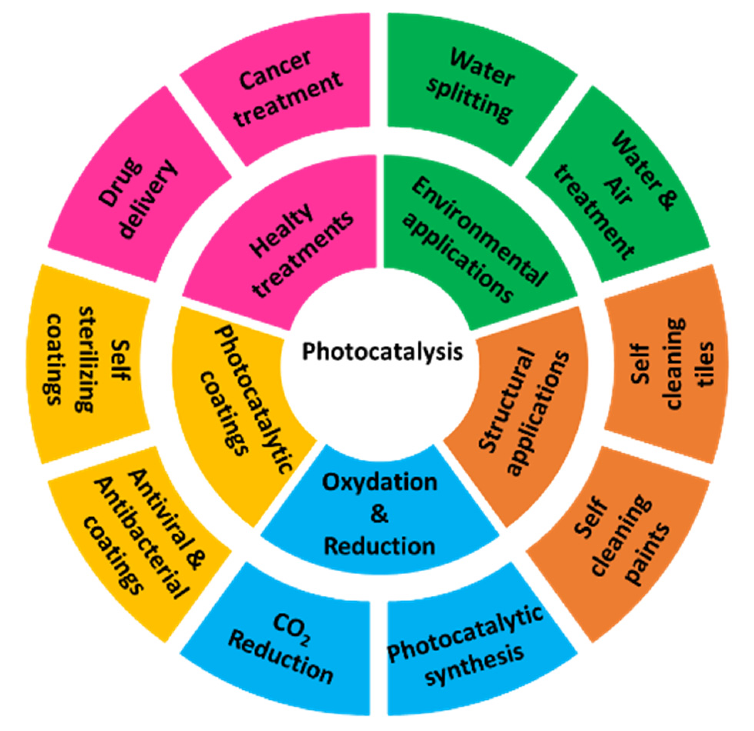
Figure 1. Application fields of photocatalysis.